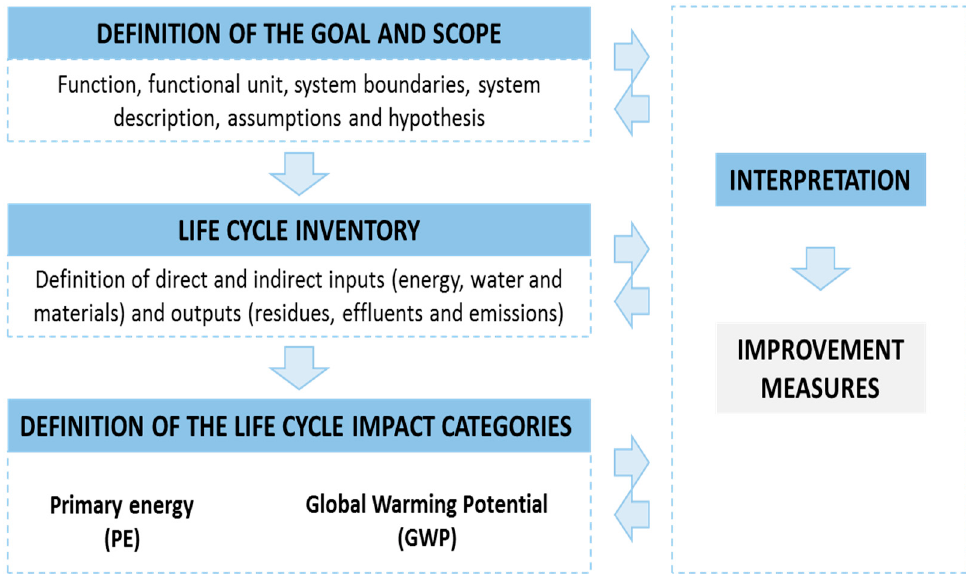
Figure 1. Life cycle oriented procedure for developing an energy certification of a building.